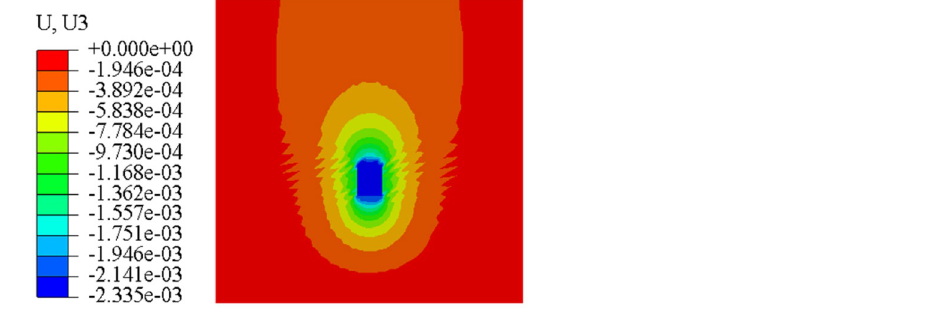
Figure 25. Top 800 mm, bottom 800 mm anchor pier stress